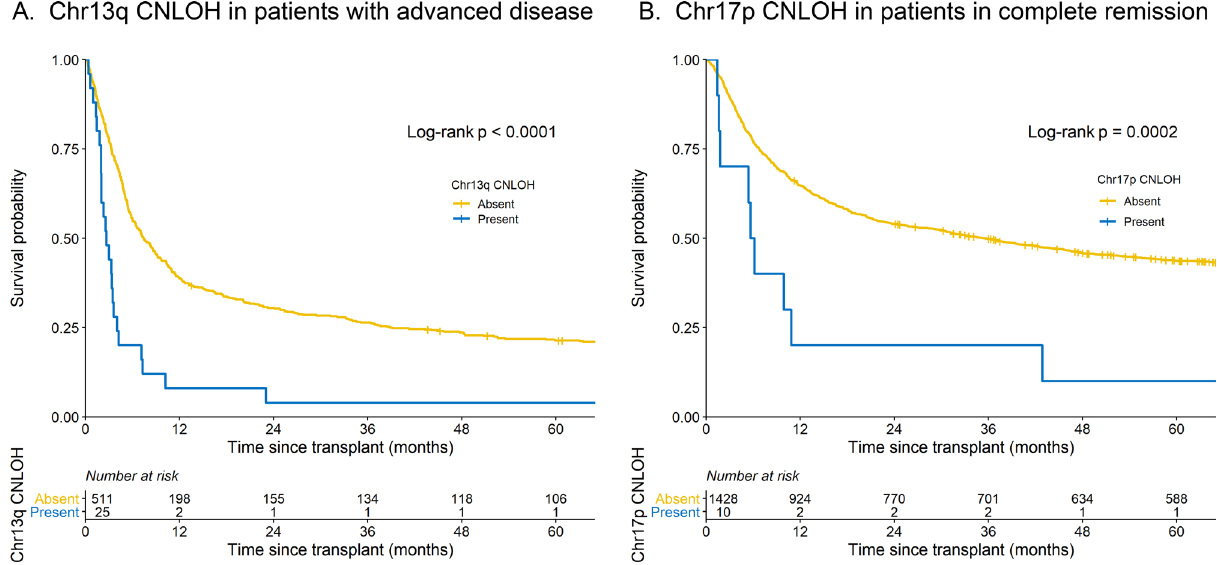
Figure 2. Survival probabilities after hematopoietic cell transplant in patients with AML: ( A ) Advanced disease (not in remission) by the presence or absence of chr13q CNLOH; ( B ) in complete remission by the presence or absence of chr17p CNLOH. Yellow: absent, blue: present.